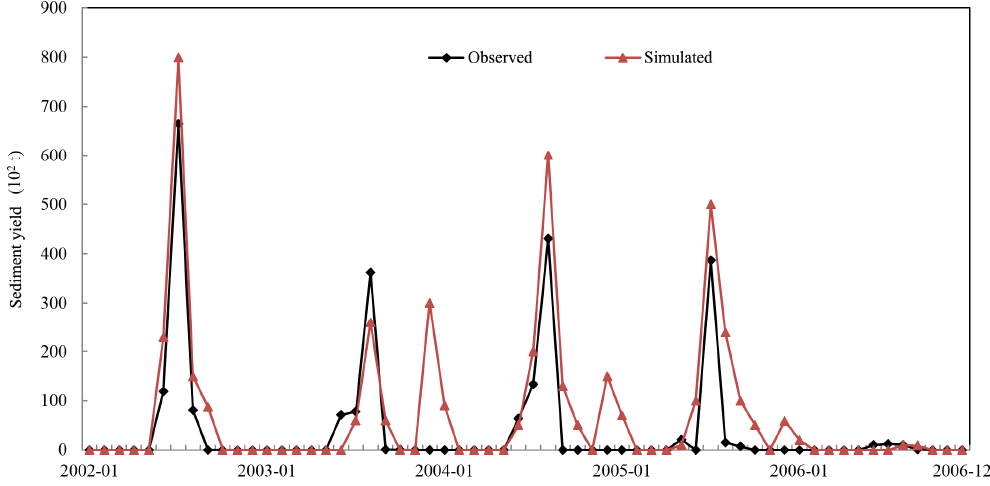
Figure 5. Comparison between the simulated and observed monthly runoff in model calibration.